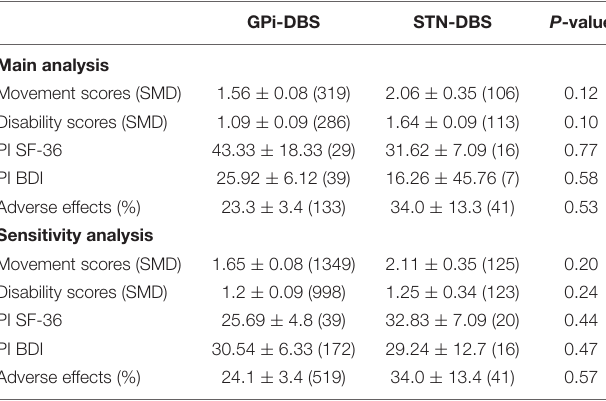
TABLE 2 | The main and sensitivity analyses of the efficacy, quality of life and adverse effects after DBS a